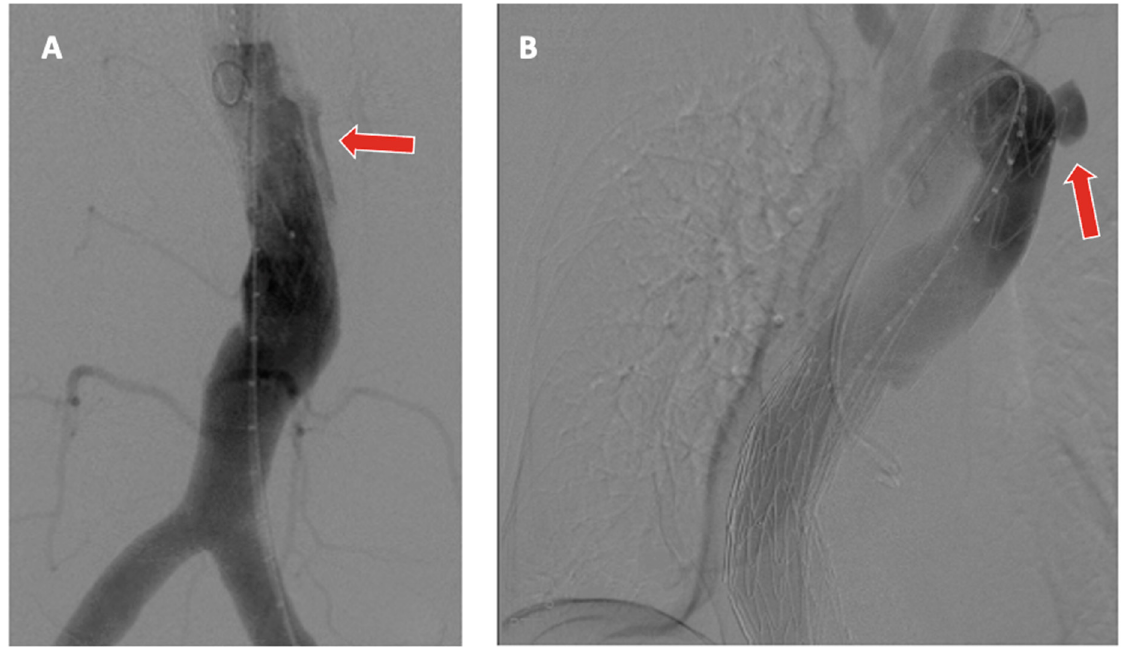
Figure 4. ( A ) Type 1B endoleak after BEVAR ( red arrow). ( B ) Aortic rupture in zone 4 (Ishimaru’s classification) after TEVAR (red arrow) and BEVAR procedure to treat a large type III